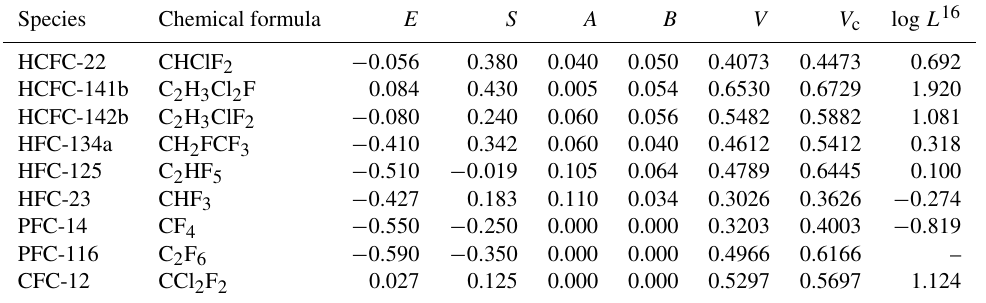
Table 4. E , S , A , B , V , V c and log L 16 descriptors of HCFC-22, HCFC-141b, HCFC-142b, HFC-134a, HFC-125, HFC-23, PFC-14, PFC- 116 and CFC-12 for the pp-LFER